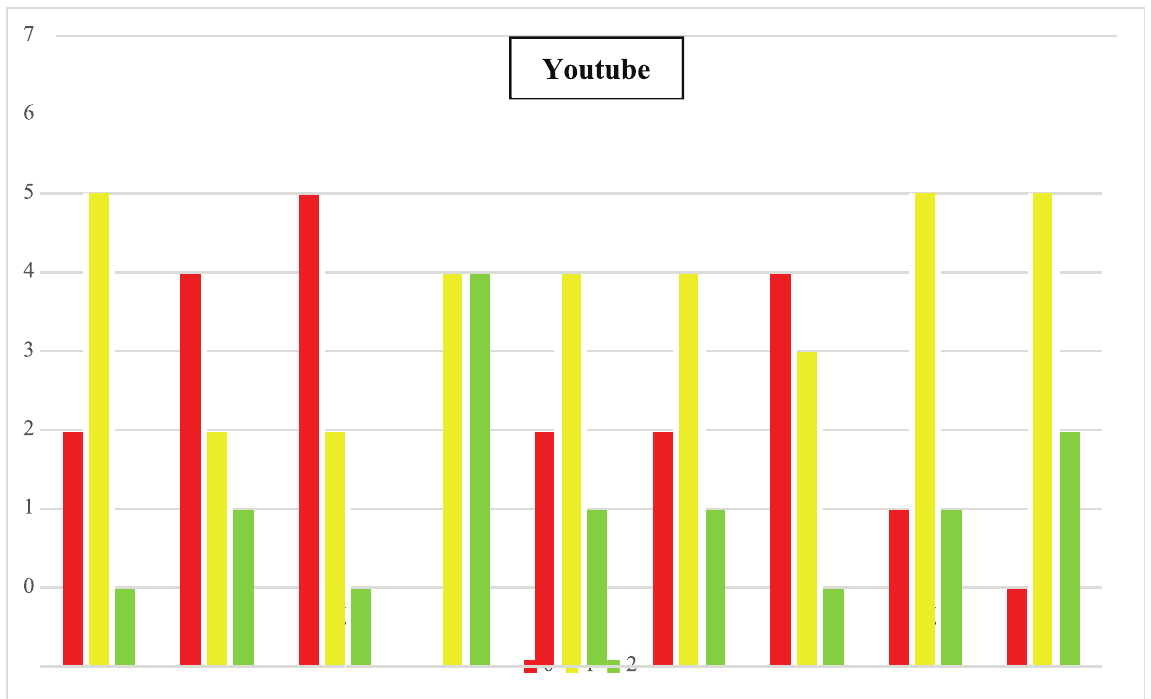
Figure 4. Distribution of scores for each of the nine items of the VuMedi videos. Q1 – Q9: Items from the assessment tool: 0 – Item not shown; 1 – Item partially presented; and 2 – Widely featured